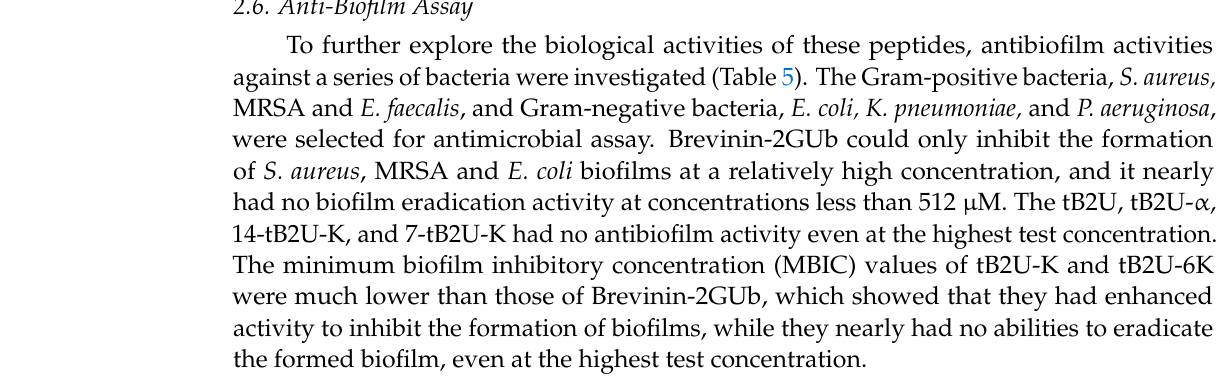
Table 5. The MBICs and minimum biofilm eradication concentrations (MBECs) of Brevinin-2GUb and its derivatives 1 .